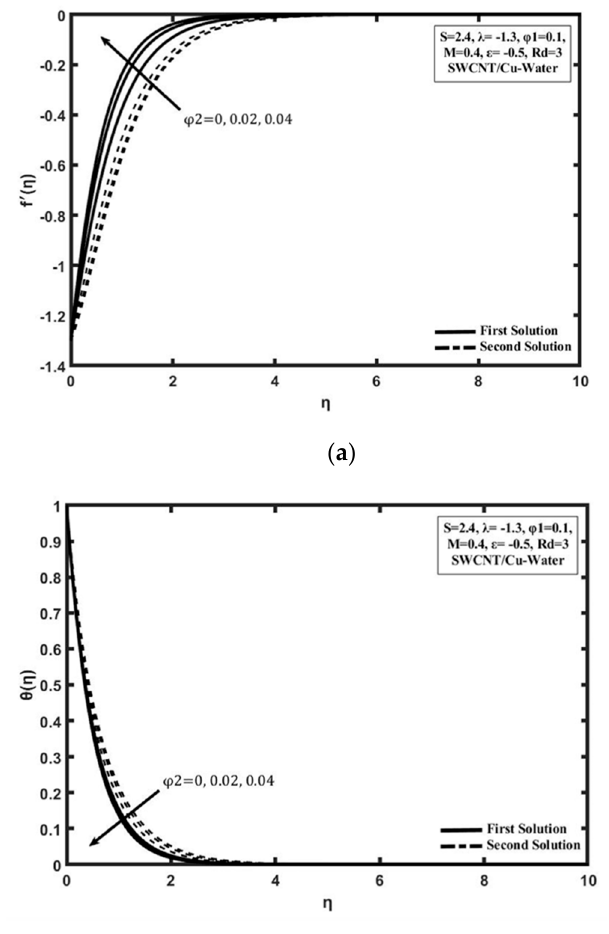
Figure 6. Profile with different (cid:2030) (cid:2870) in SWCNT/Cu–water nanofluid when S = 2.4, (cid:2019) = −1.3 , (cid:2030) (cid:2869) = 0.1, M = 0.4, ε = − 0.5, Gr = 0, and Rd = 3: ( a ) velocity profile variation f ′ ( (cid:2015) ); ( b ) temperature profile θ ( (cid:2015)